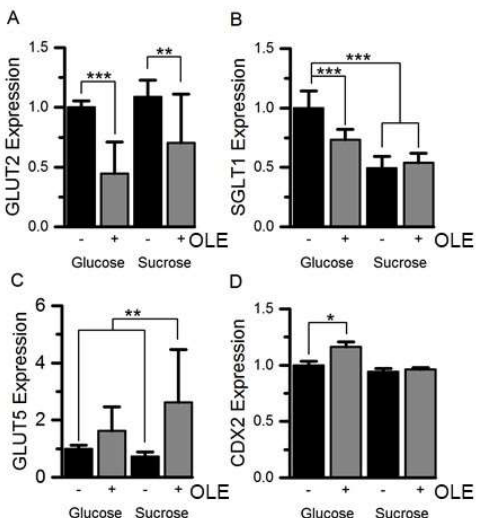
Figure 2. The effect of OLE on GLUT2, SGLT1, GLUT5 and CDX2 mRNA expression. GLUT2 (panel A ), SGLT1 (panel B ), GLUT5 (panel C ) and CDX2 (panel D ) mRNA expression in Caco-2/TC7 cells, cultured in 25 mM glucose or 25 mM sucrose for 21 days and treated with 1.5 mg/mL OLE for the final 3 days, was measured relative to TBP. Results are normalised to the glucose control and presented as mean ± SEM, *** p < 0.001, ** p < 0.01, * p < 0.05; n = 9, with 3 technical replicates; + indicates with OLE, - indicates without.